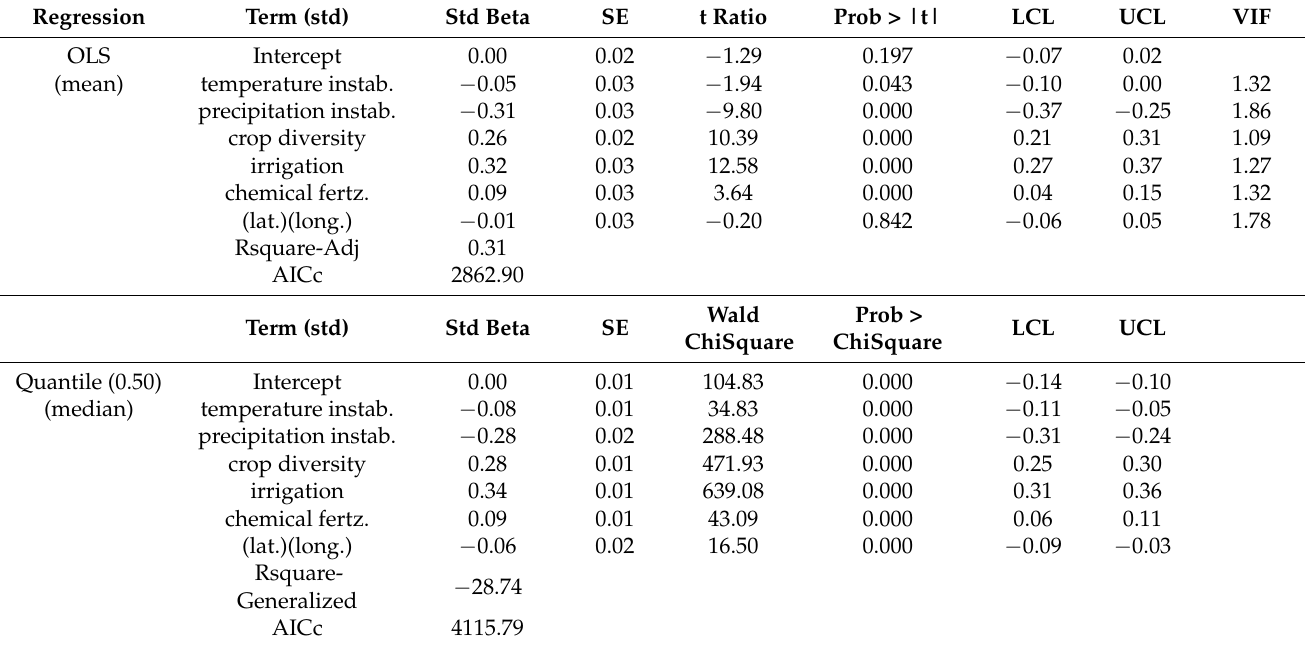
Table A2. Results of Model 1, ordinary least squares (OLS) and quantile (median) regressions.